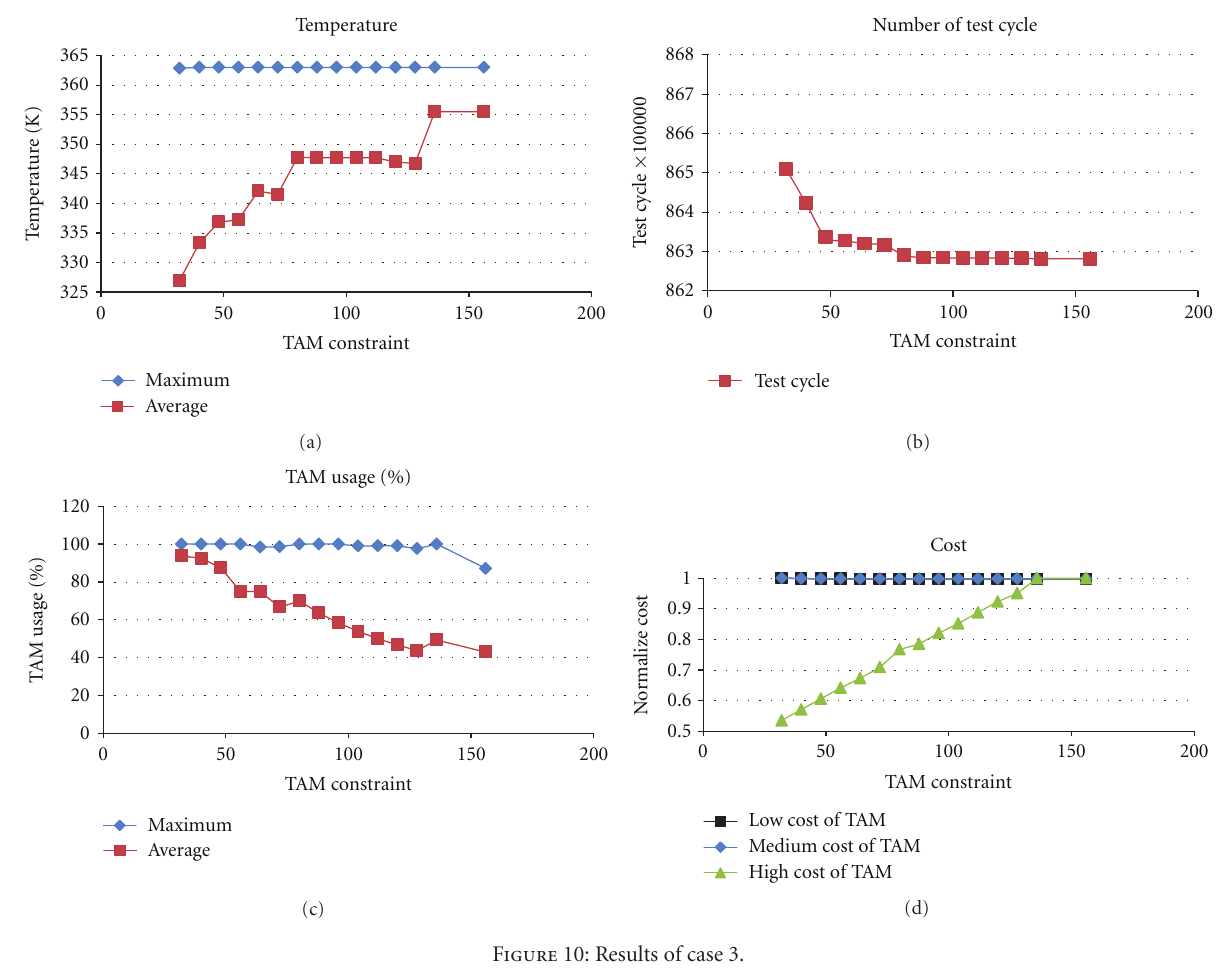
Figure 10: Results of case 3.